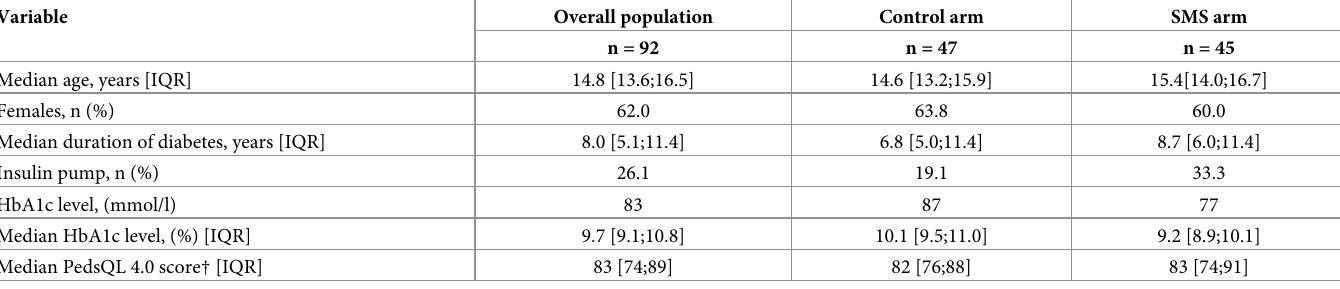
Table 1. Baseline characteristics of the study participants according to